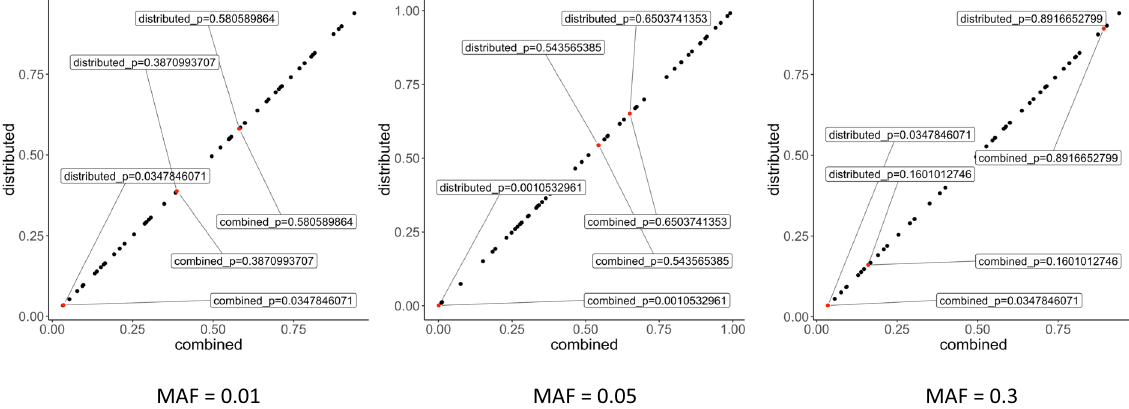
Fig. 3 Correlation plot of p-values between Sum-Share and gold-standard analysis. SNPs and phenotypes were randomly selected from the eMERGE data to assess their associations. The SNPs were grouped into three categories according to their minor allele frequency (MAF = 0.01, 0.05, or 0.3) corresponding to left, middle, and right panels. P -values from the associations between each SNP and all phenotypes were obtained from either the distributed analysis (Sum-Share) or from the pooled individual-level data analysis (combined). Three SNPs in each category were randomly selected to display the corresponding p -values (up to the 10th signi fi cant